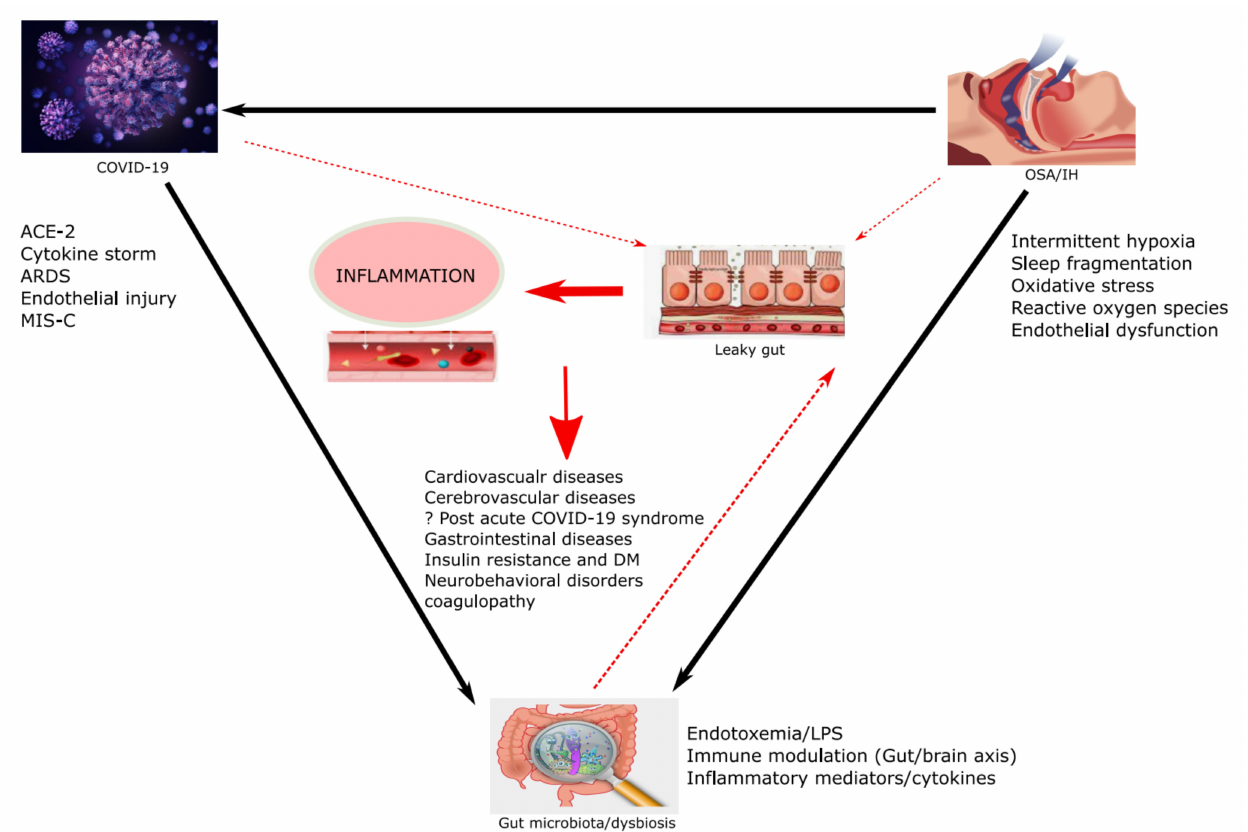
Figure 3. The inter-relationship between COVID-19, obstructive sleep apnea, and the gut microbiome. ACE-2 = Angiotensin-Converting Enzyme 2; MIS-C = Multisystem inflammatory syndrome in children; OSA = obstructive sleep apnea; IH = intermittent hypoxia; ARDS = acute respiratory distress syndrome; LPS = Lipopolysaccharide; DM = diabetes